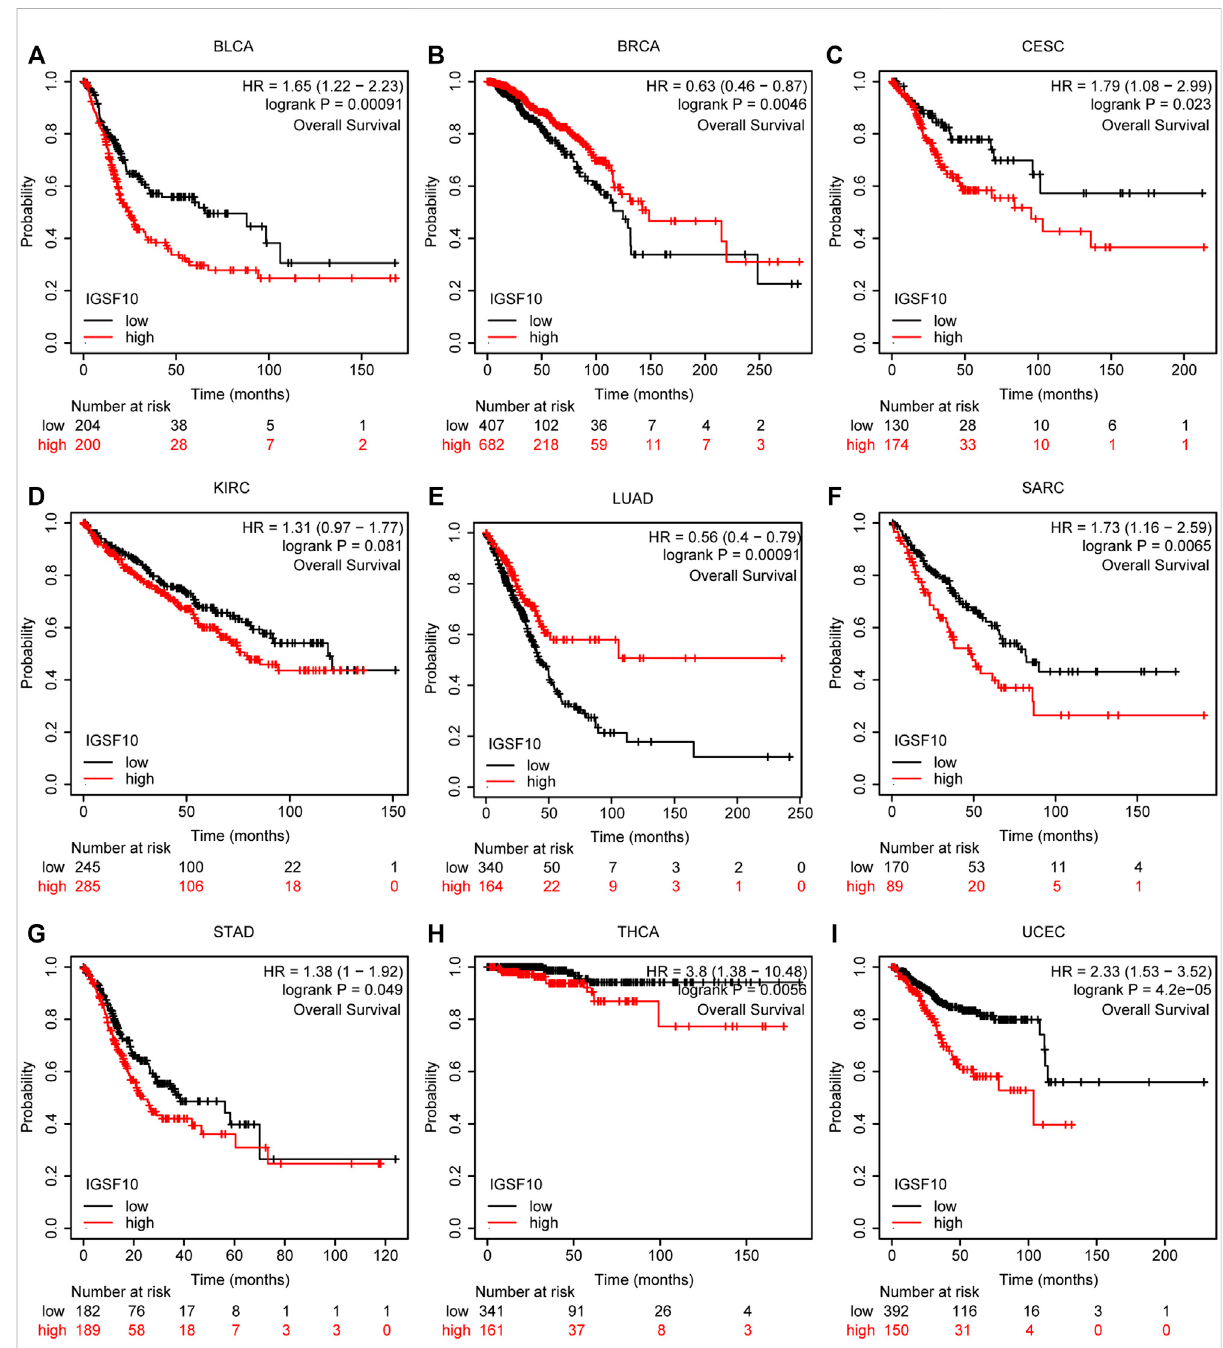
FIGURE 6 Associations between IGSF10 expression and OS. (A – I) Correlations between the IGSF10 expression and OS based on Kaplan-Meier Plotter